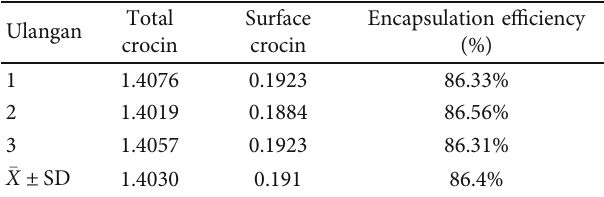
Table 6: Encapsulation e ffi ciency of sa ff ron essential oil